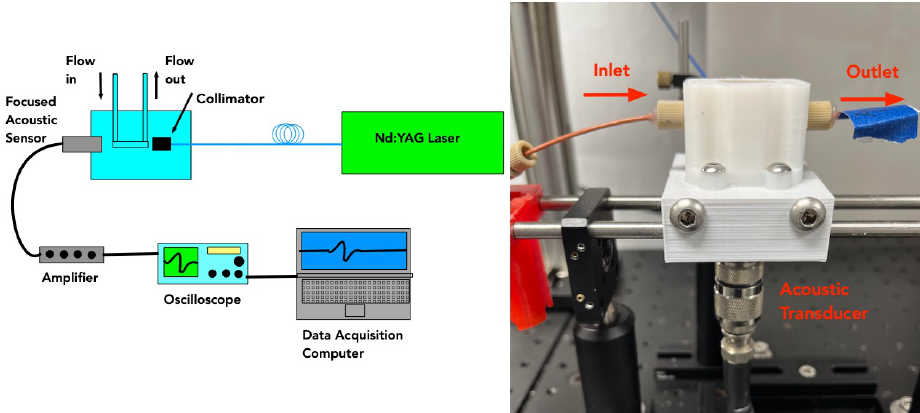
Figure 1. ( Left ) Schematic showing photoacoustic setup used for testing Staph. aureus samples. ( Right ) The actual flow chamber is